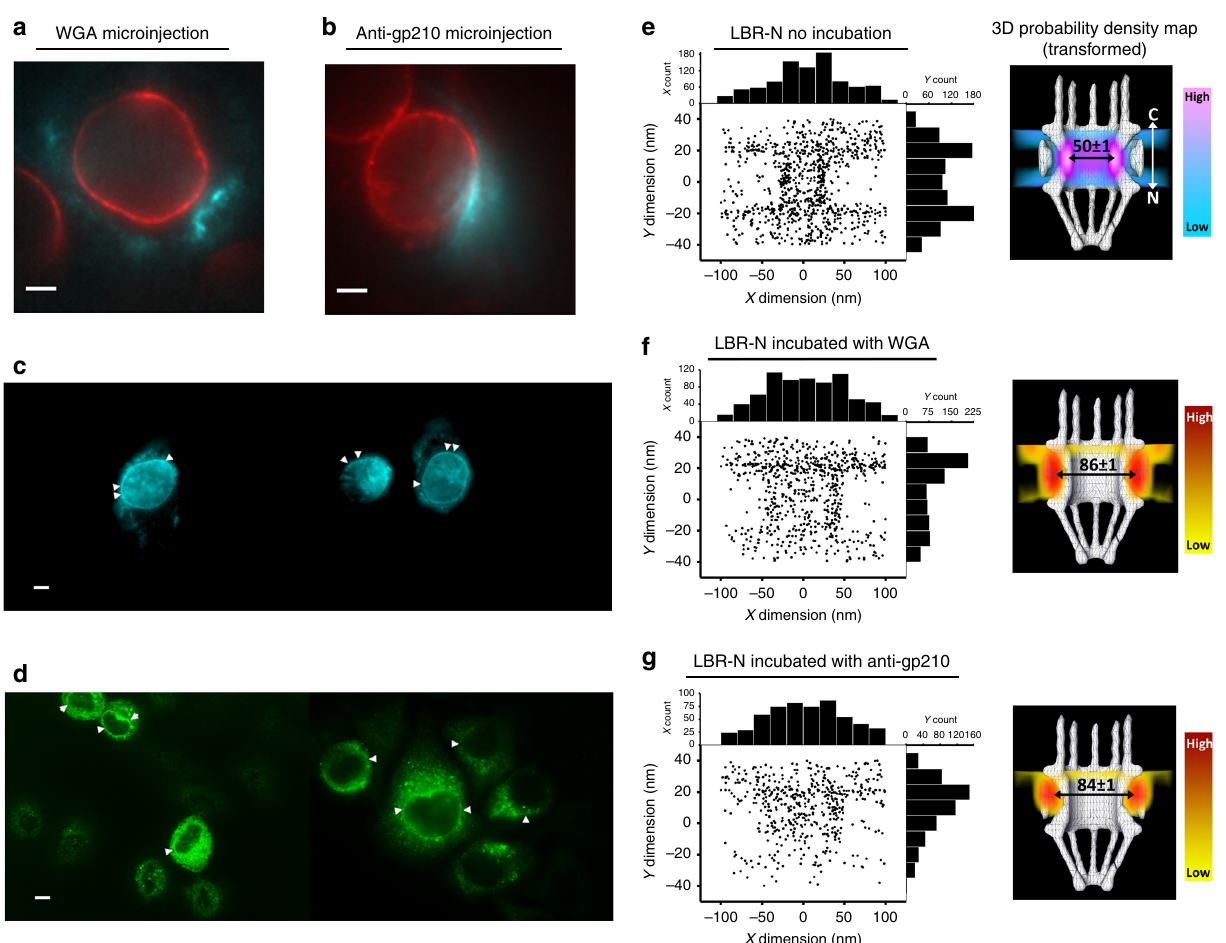
Fig. 5 Transport routes for unaltered LBR with the presence of WGA or anti-gp210. a , b HeLa cells expressing PoM121-mCherry (red) and LBR-N (GFP, not shown) immediately after microinjection with WGA conjugated to Alexa Fluor-647 (cyan) or a mixture of anti-gp210 and Alexa Fluor-647 (cyan, scale bar: 5 µ m; at least eight biological replicates). c Fluorescent image of HeLa cells incubated with WGA (cyan) for 30 min (scale bar: 5 µ m; at least three biological replicates). d Immuno fl uorescent image of HeLa cells after permeabilization and incubation with anti-gp210 (Alexa-488 conjugated secondary antibody, green) for 30 min (scale bar: 5 µ m, at least three biological replicates). e – g On the left, projected 2D spatial localizations of unaltered LBR in live cells without and with microinjection of WGA or anti-gp210 (top to bottom). Histograms showing the number of LBR ’ s locations in the x (top) and y (right) dimensions. On the right, 3D probability density map generated as previously mentioned (each color bar shows the gradient color change between regions of high and low